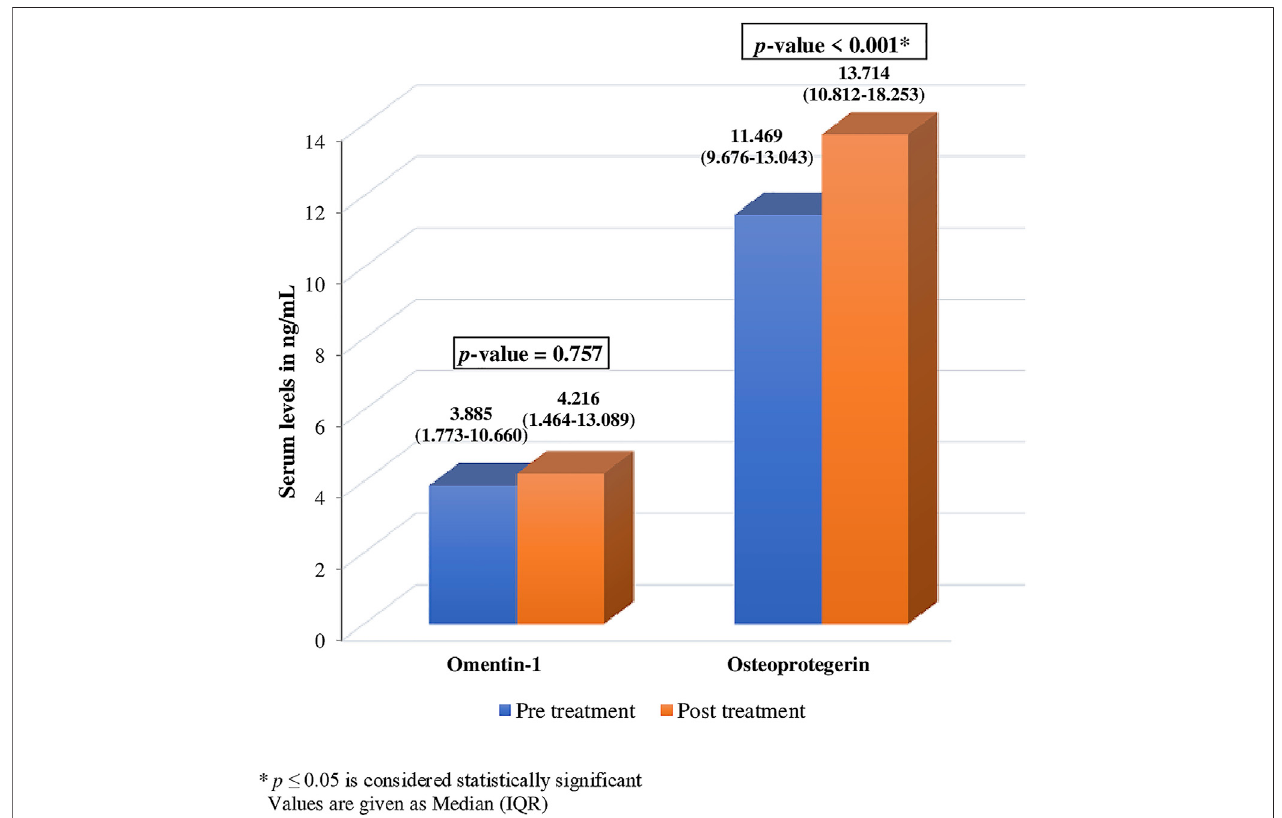
FIGURE 3 | Comparison of pre and post treatment levels of serum omentin-1 and osteoprotegerin.